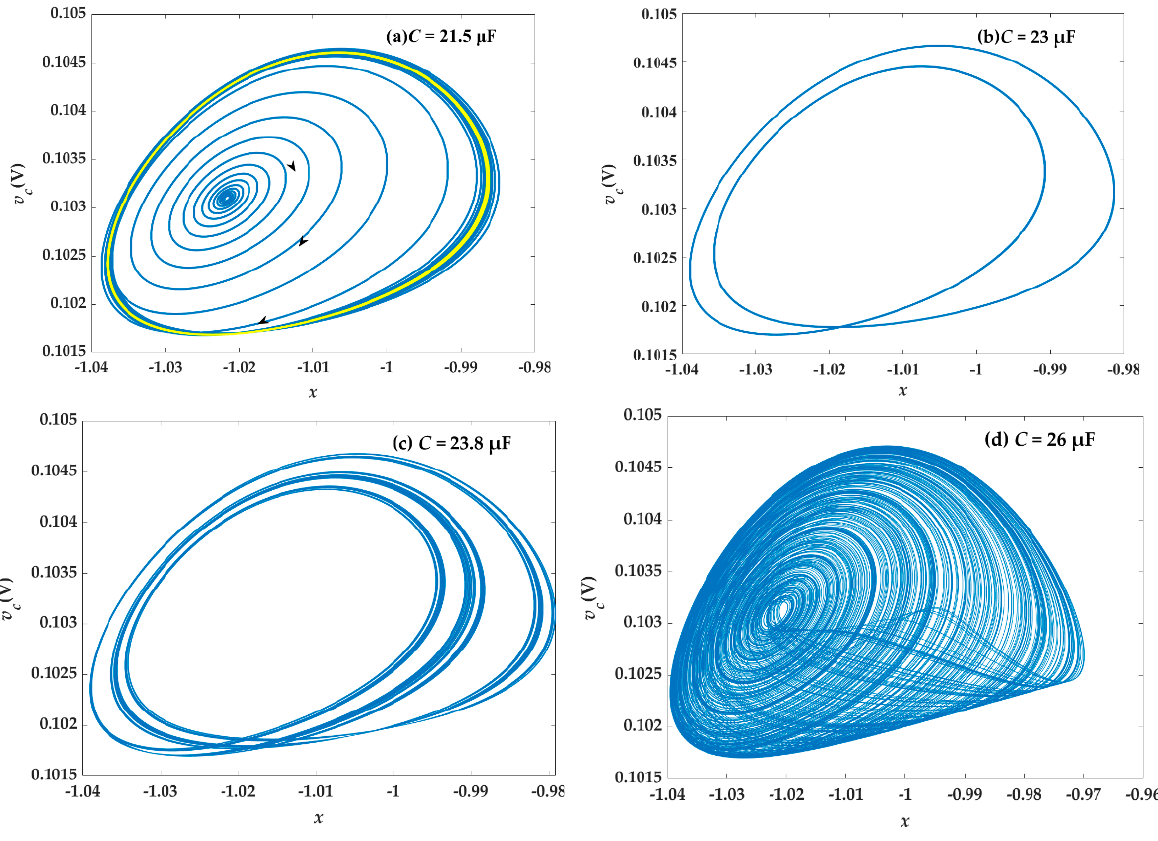
Figure 19. Variation in system attractor with capacitance C , where V = 0.1031 V, L = 0.96 H. ( a ) C = 21.5 μ F, ( b ) C = 23 μ F, ( c ) C = 23.8 μ F, ( d ) C = 26 μ F.